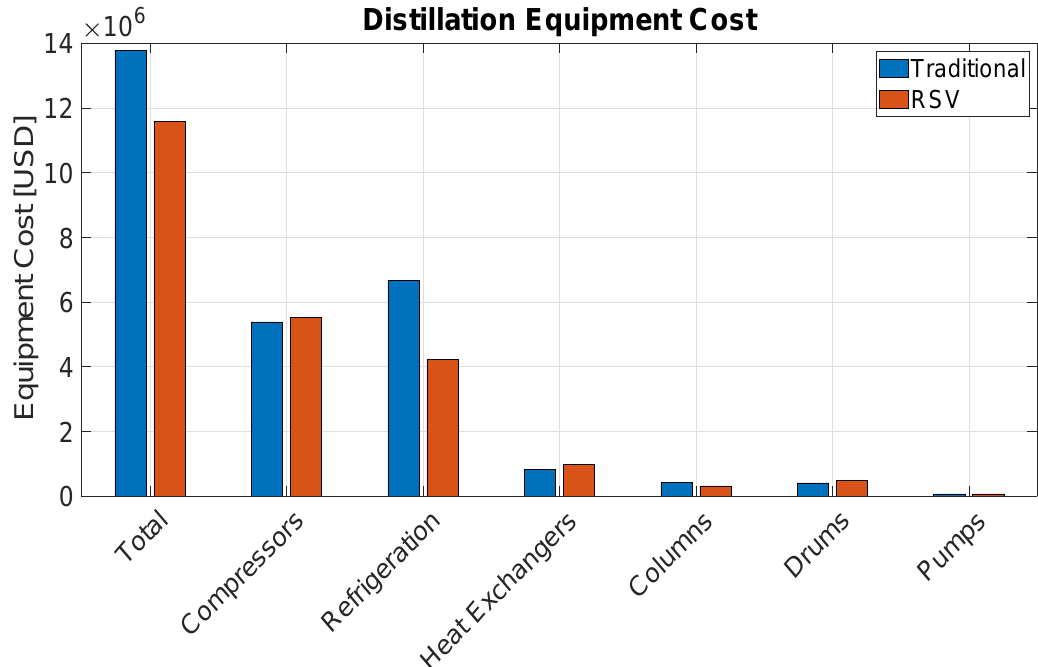
Figure 14. Cost of different equipment installed in the distillation section for the two compared process configurations. Reproduced with permission from Penteado, Ph.D. Thesis, TUB, 2021